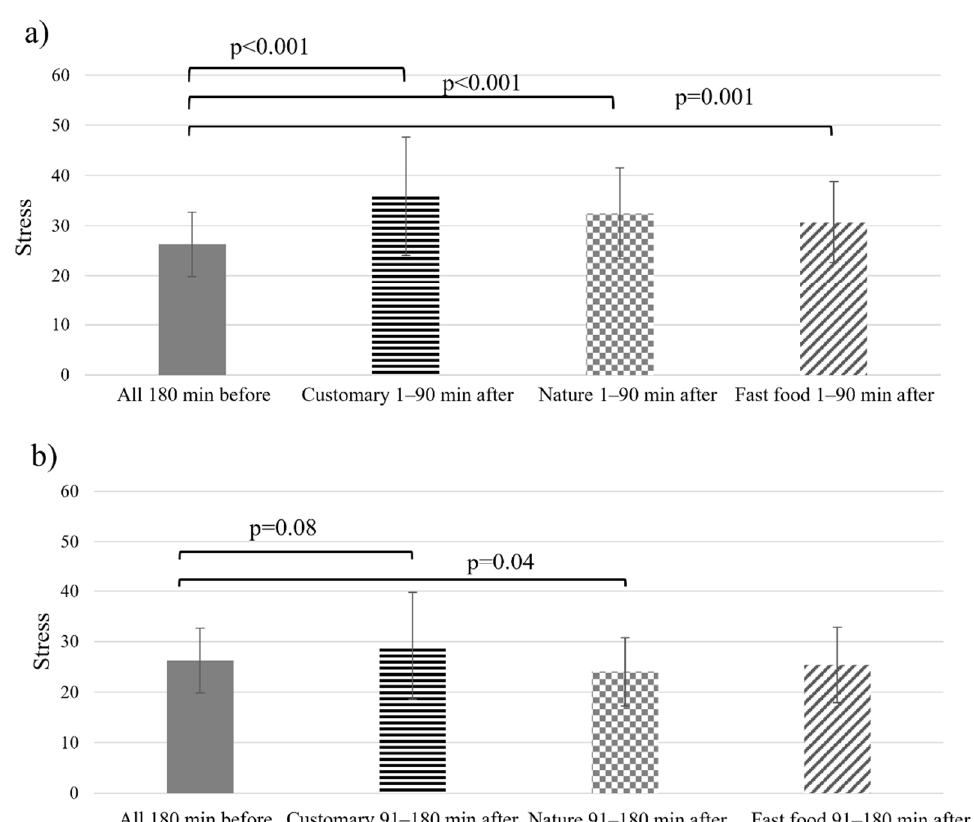
Figure 5. Averages of median objective stress 180 min before lunch (all weeks combined) and ( a ) 1–90 min after lunch and ( b ) 91–180 min after lunch. Scale: 0–25 = resting state, 26–50 = low stress, 51–75 = medium stress, 76–100 = high stress. Error bars are standard deviations of the medians. Data from the subgroup of participants ( n = 32).